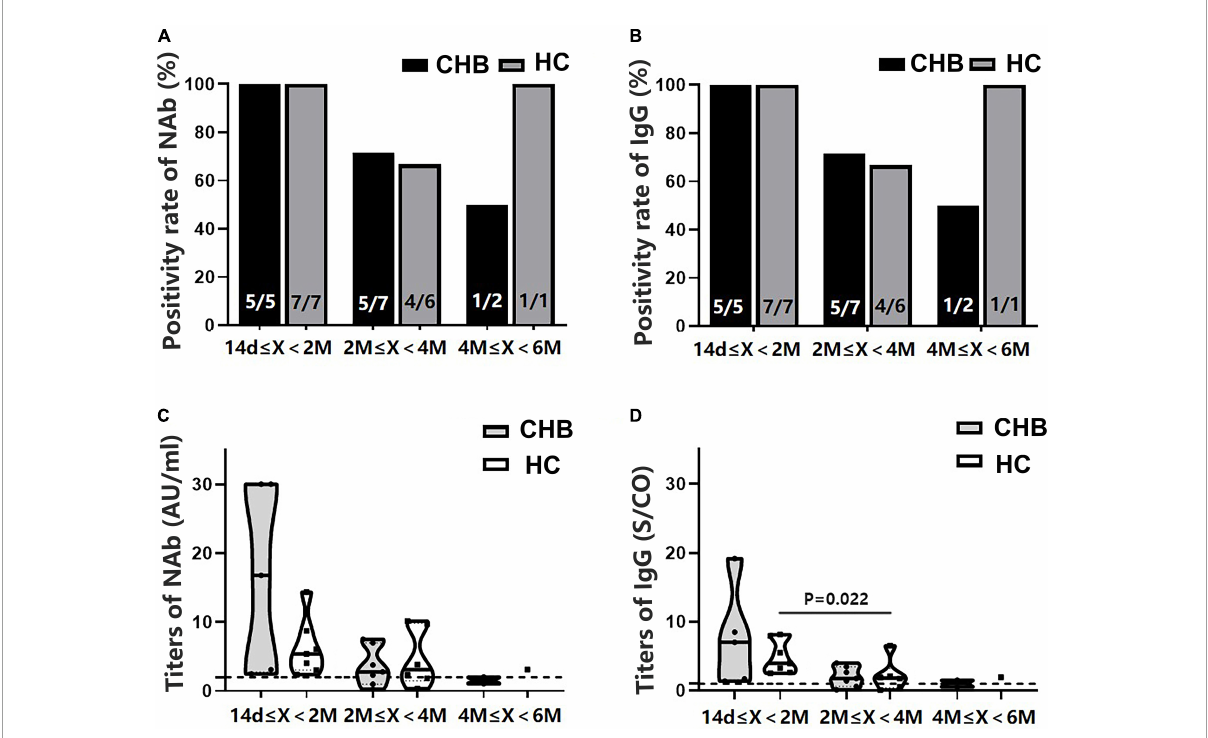
FIGURE5 Comparison of the positivity rates and titers of antibodies after the second dose between patients with CHB and HCs after propensity score matching. (A,B) Comparison of the NAb and immunoglobulin G (IgG) positivity rates between the two groups at different time intervals. (C,D) Comparison of the NAb and IgG antibody titers between the two groups at different time intervals; n1/n2 in bars, positive cases/all cases; X, days after the second dose; dotted line, cutoff value; CHB, chronic hepatitis B; HCs, healthy controls; NAb, neutralizing